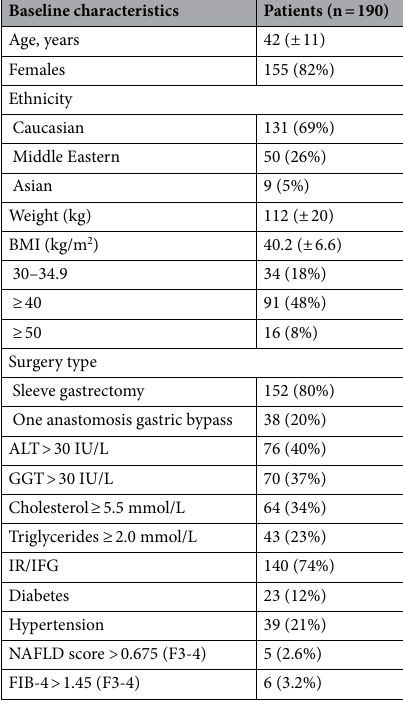
Table 1. Baseline characteristics. BMI Body Mass Index, ALT Alanine aminotransferase, GGT Gamma glutamyltransferase, IR Insulin resistance, IFG impaired fasting glucose. Results are reported as frequency (percentage) or mean (SD) as appropriate.